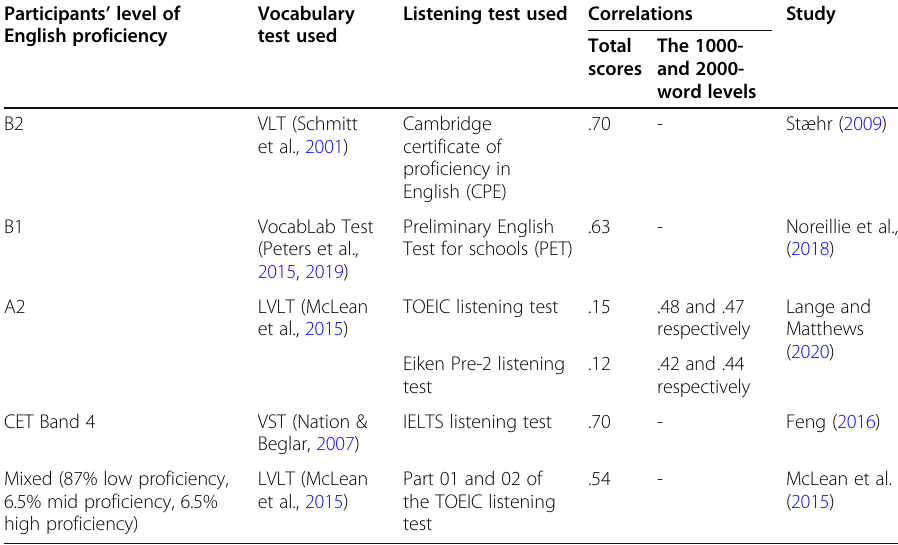
vocabulary tests and listening